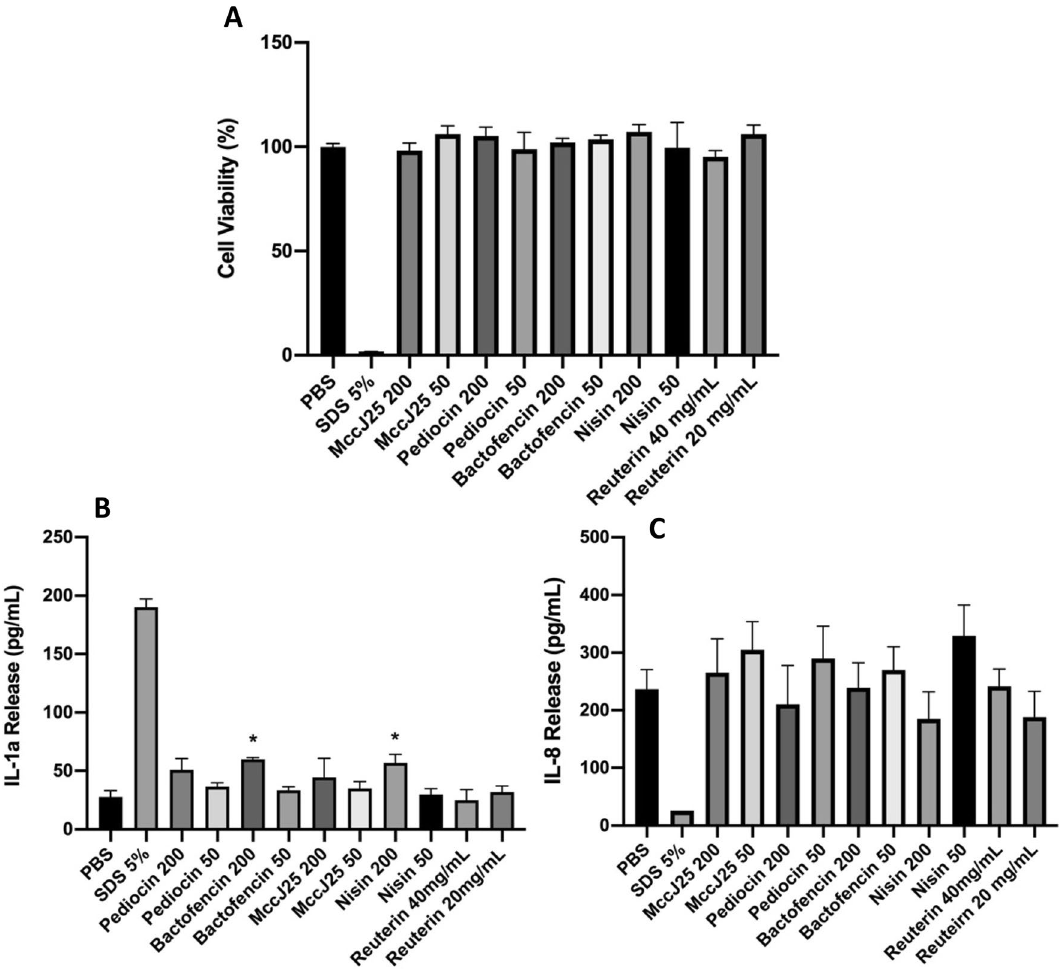
Figure 5. ( A ) Viability of the tissue (EpiDerm) after exposure to selected bacteriocins and reuterin. ( B ) IL-1α cytokine release. ( C ) IL-8 cytokine release. All data are represented as the mean ± SD for three replicates (n = 3). * P < 0.05 vs.